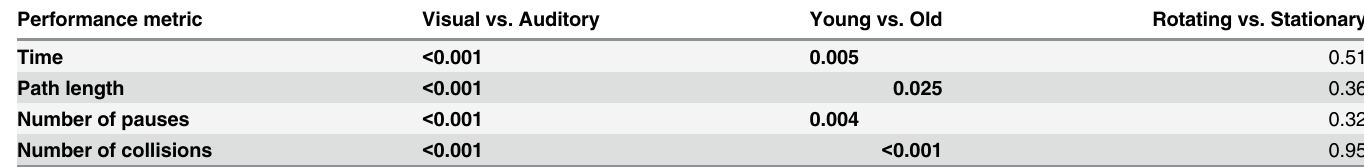
Table 2. P-values for the main effects per performance metric. P-values < 0.05 are marked in bold. Performance metric Visual vs.